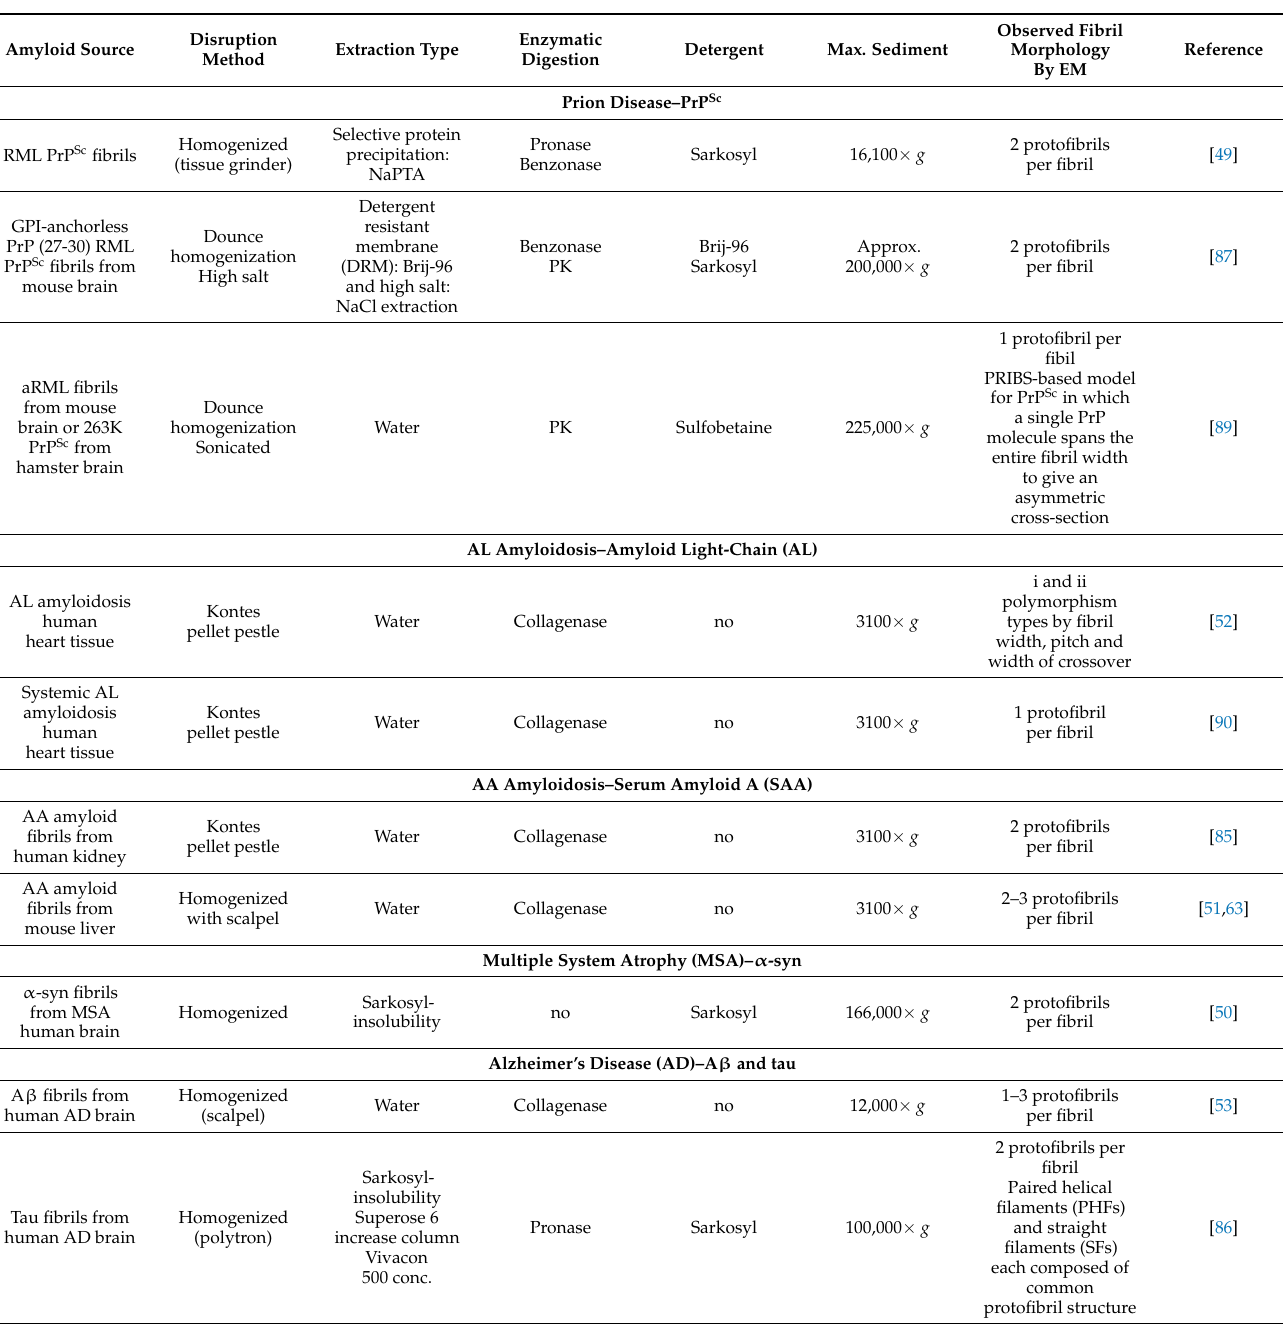
Table 1. Comparison of ex vivo fibril isolation methods from diseased tissues and the resulting fibrillar morphologies determined by cryo-electron